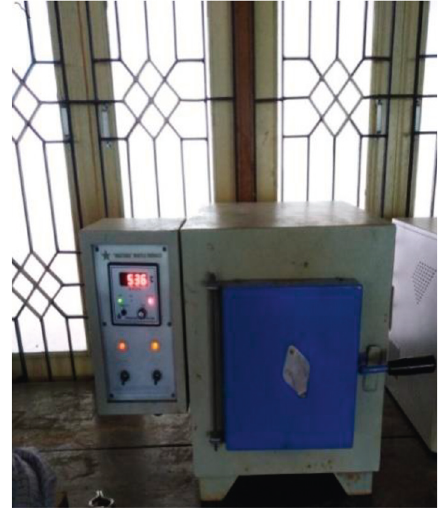
Figure 3: Stress relief anneal.